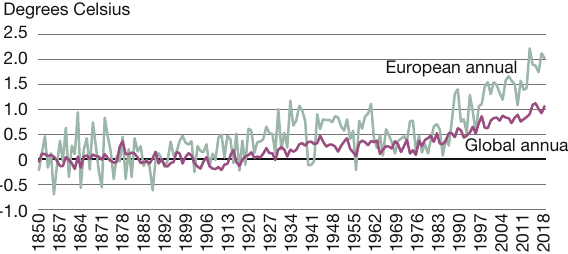
Global and European average near-surface temperatures relative to pre-industrial period 1850-